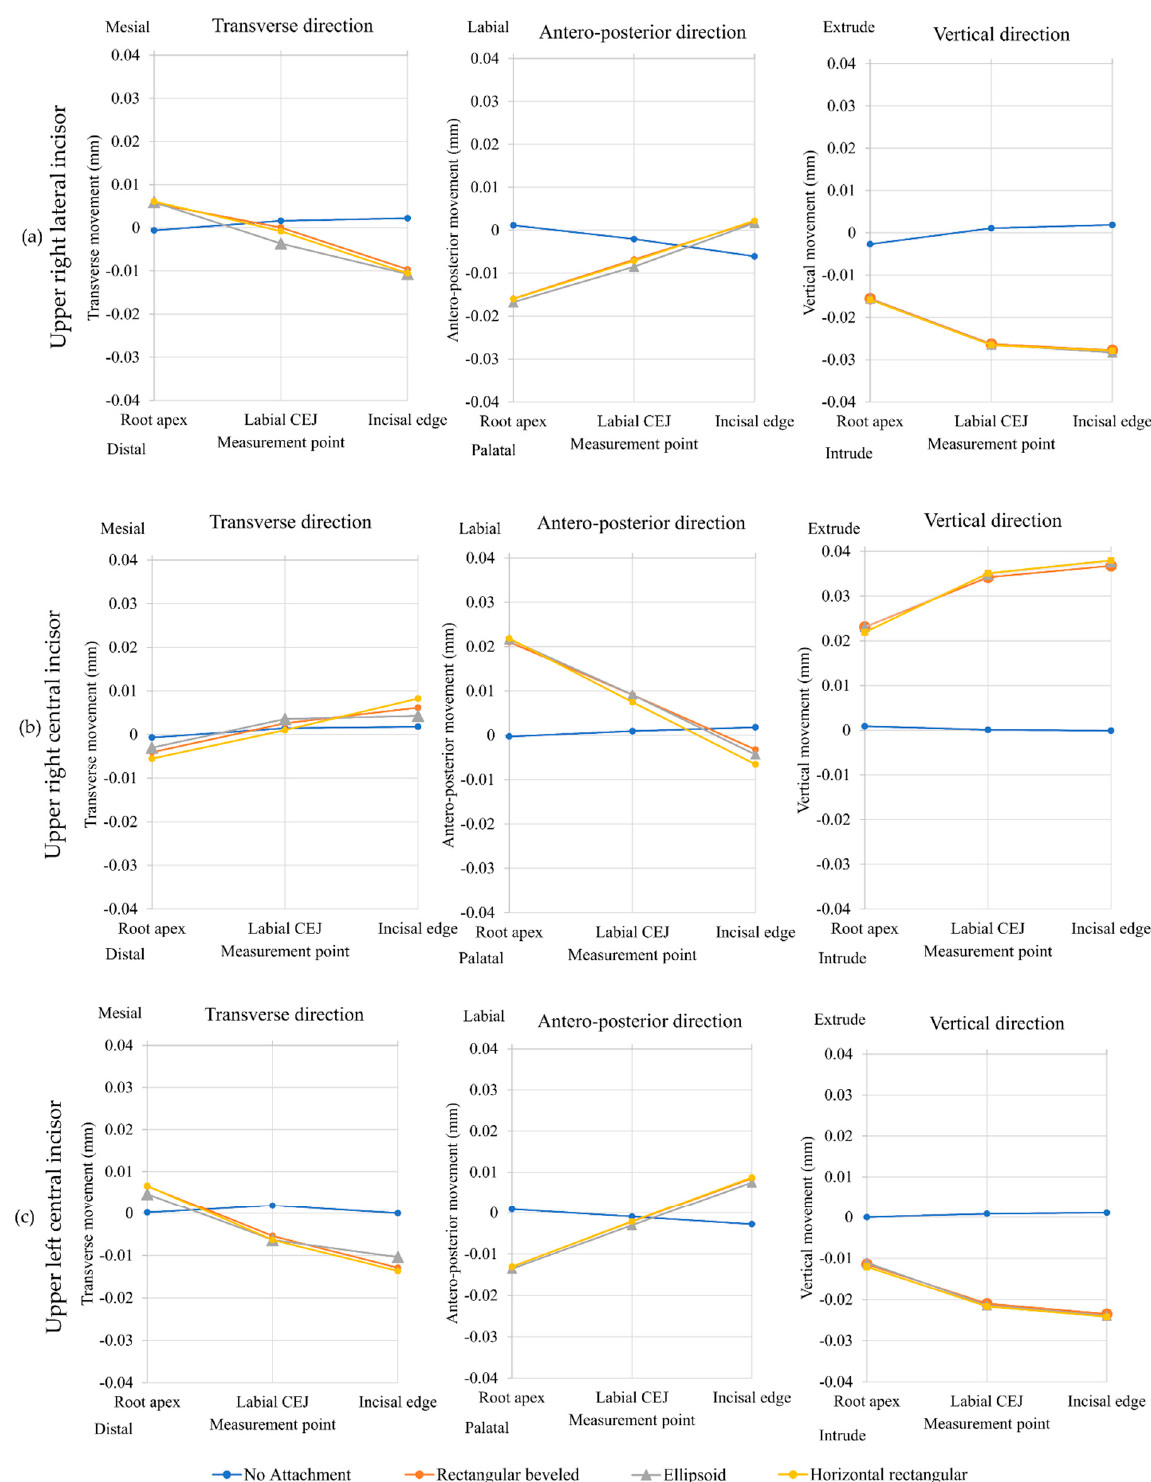
Figure 4. Nodal displacement results: ( a ) upper right lateral incisor, ( b ) upper right central incisor, and ( c ) upper left central incisor.